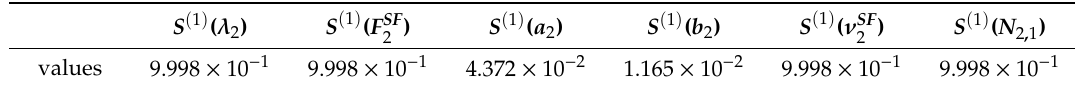
(cid:16) (cid:17) q j for isotope 240